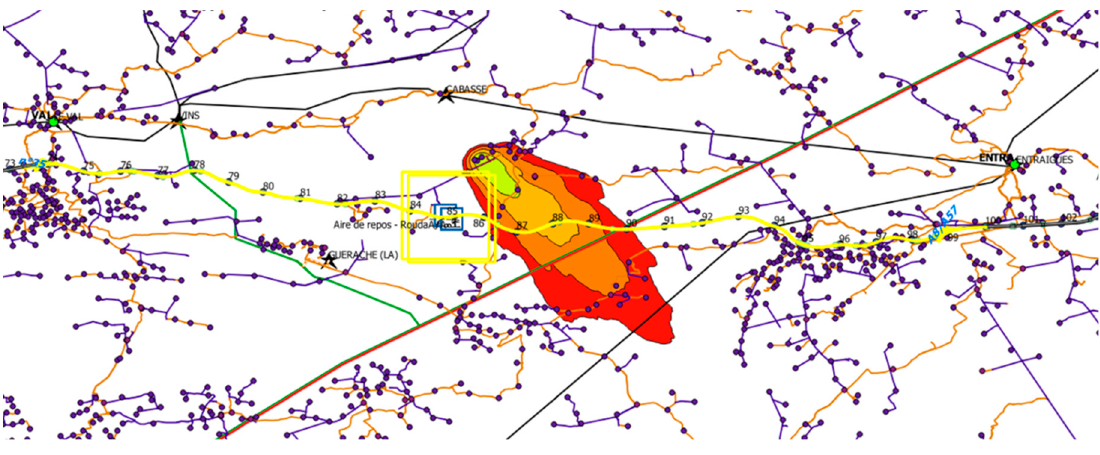
Figure 12. Highway projected impacts due to fire